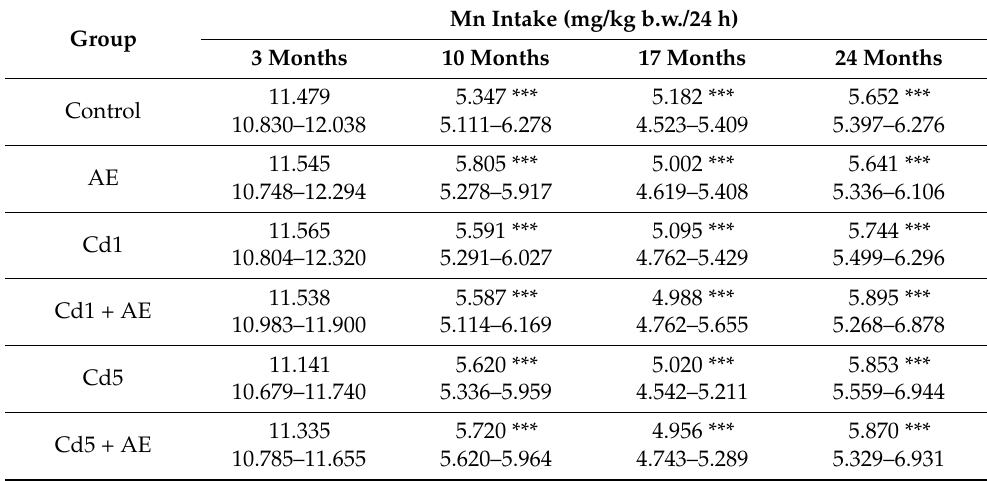
Table 2. The intake of Mn with the Labofeed diets in particular experimental groups 2